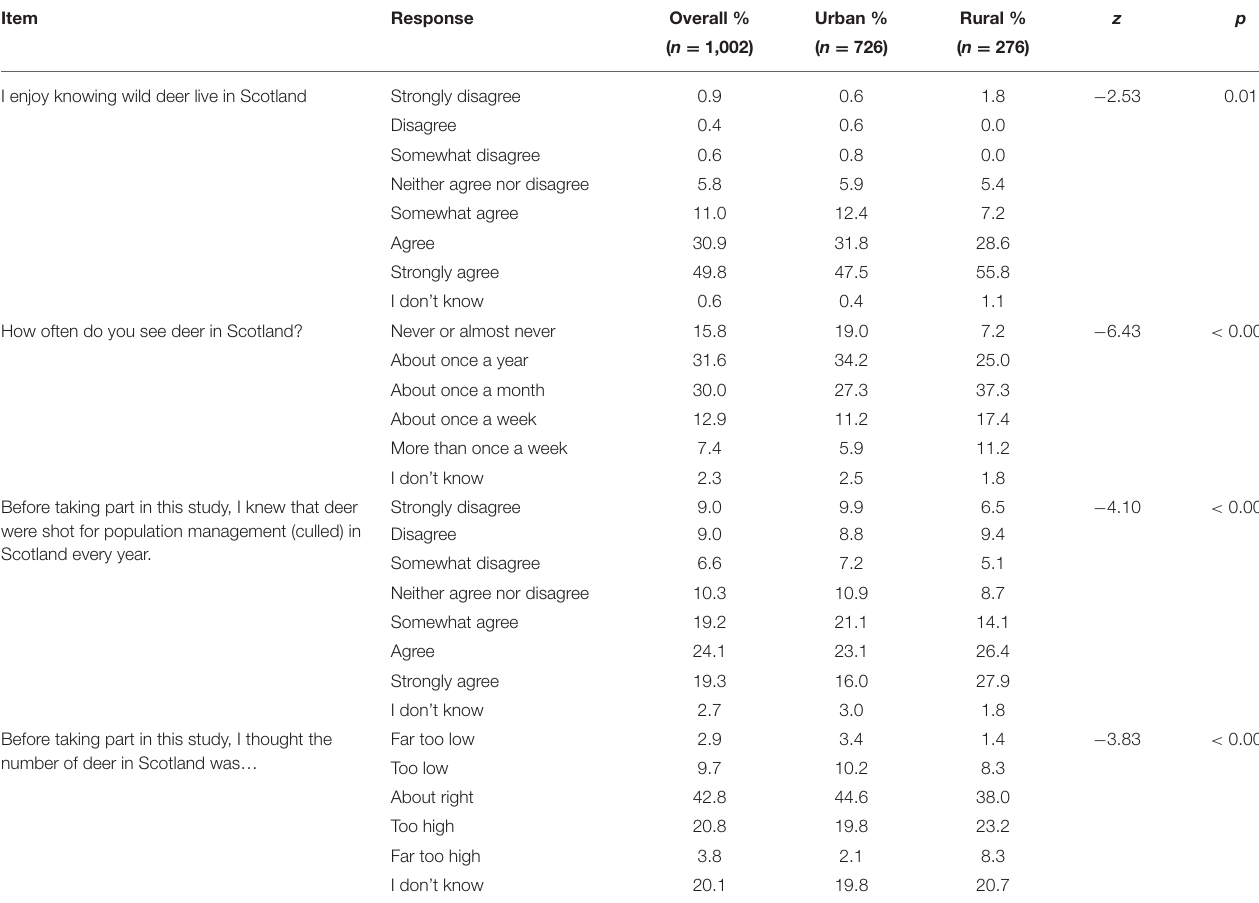
TABLE 2 | Experiences and general perceptions of deer, and relevance of ethical considerations for overall sample and split by rural and urban respondents.